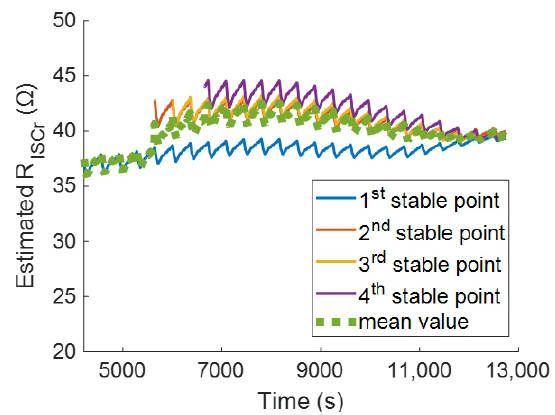
Figure 7. Estimated R ISCr s from different stable points in experiment with true R ISCr 49.91 Ω and DST current